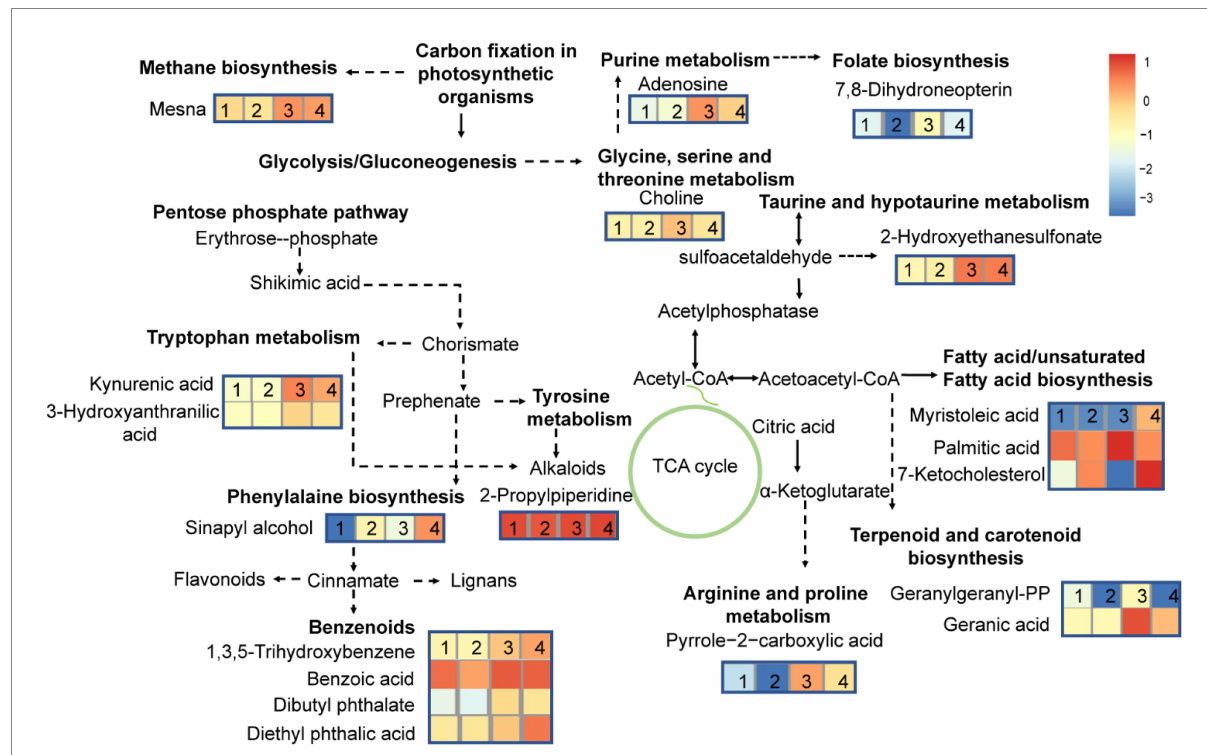
FIGURE 7 Differential metabolites pathways in MC-producing and MC-free strains harvested at exponential- and stationary-growth phases. The numbers 1, 2, 3, and 4 represent MCE, MCFE, MCS, MCFS, respectively. MCE, MC-producing strain at exponential phase; MCFE, MC-free strain at exponential phase; MCS, MC-producing strain at stationary phase; MCFS, MC-free strain at stationary phase.